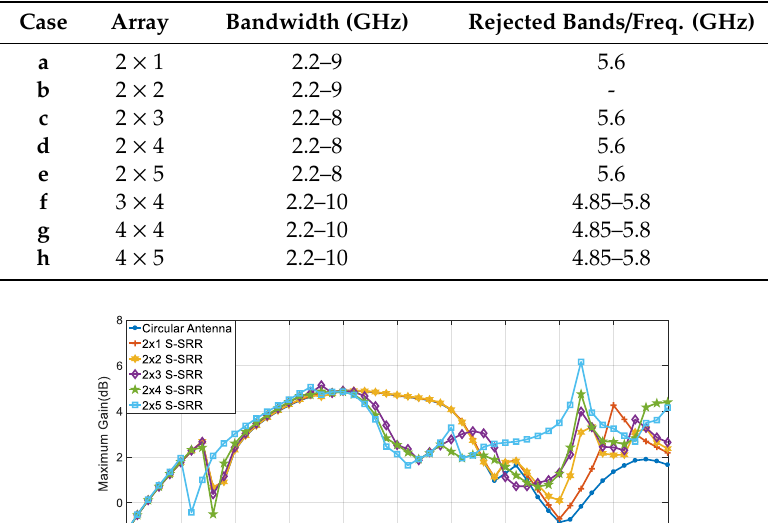
Figure 42. Radiation pattern for 2 × 4 array, ( a ) Phi = 0° ( b ) Phi = 90°.